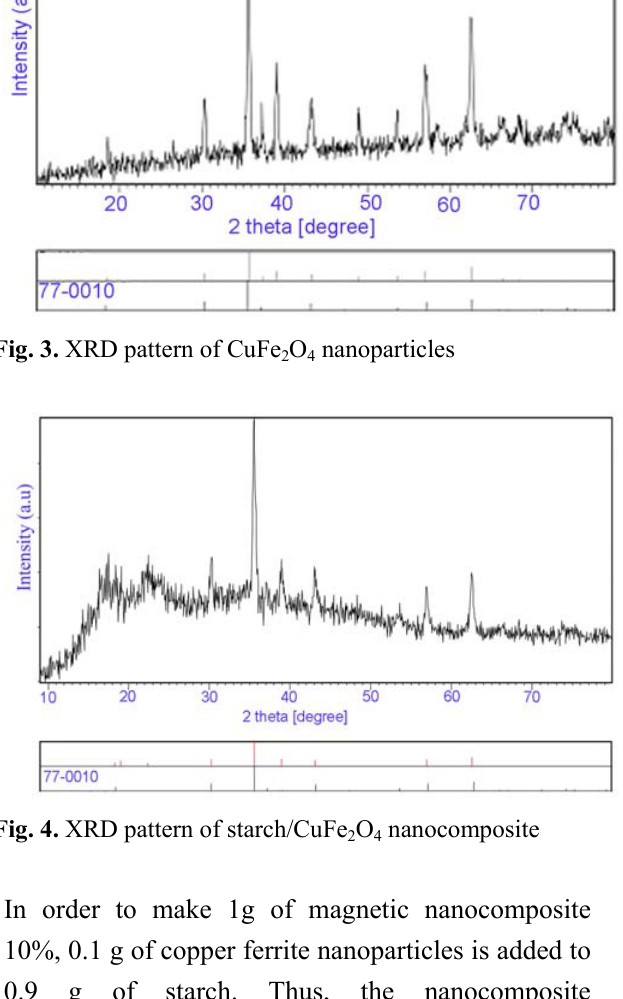
Fig. 2 . Schematic diagram of preparation the nanocomposites